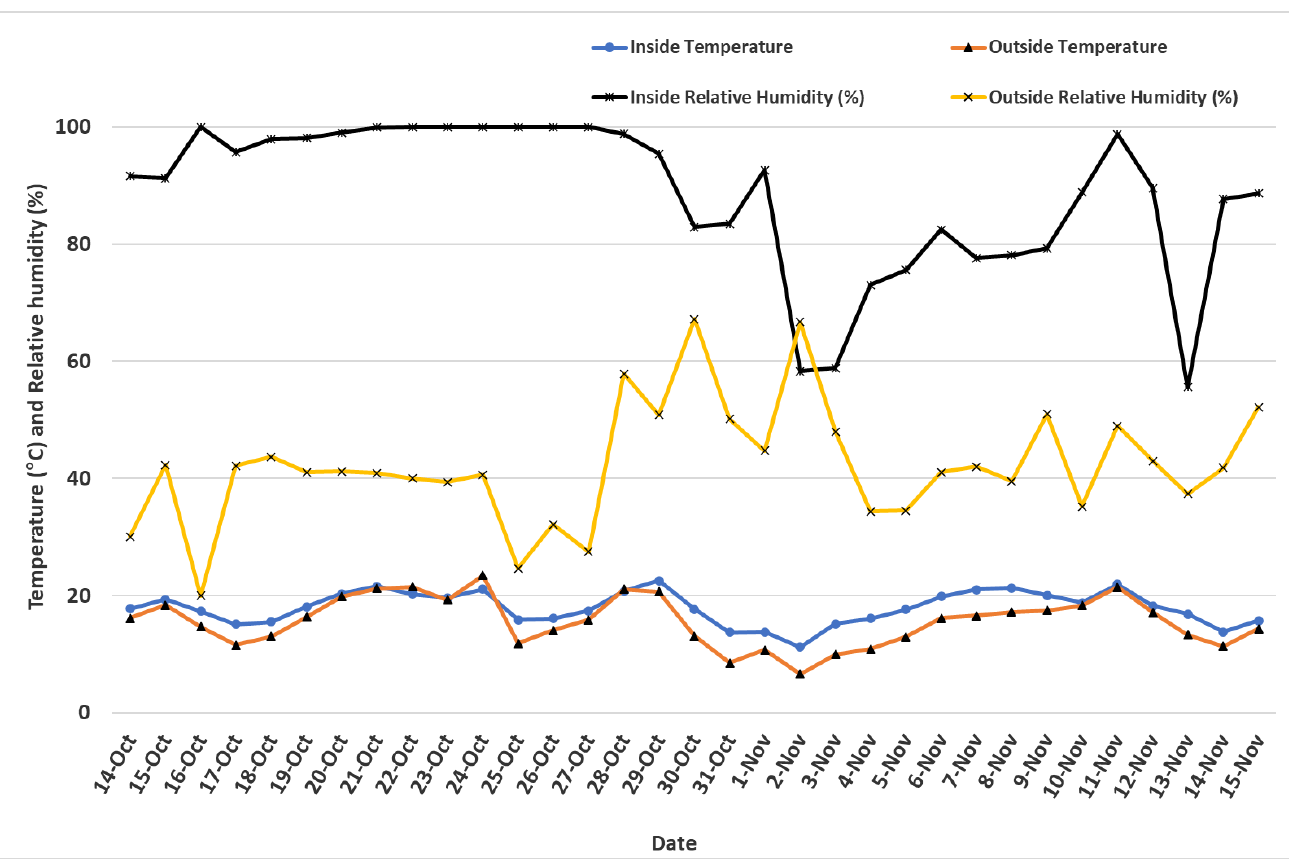
Figure 5. Contrast of temperature (°C) and relative humidity (%) inside and outside the high tunnel (HT) where the trial was conducted. A TinyTag ® data logger was placed at ground level in the middle of the HT and another one placed on a raised bed outside the HT where ginger plants were grown. Soil microbial profile. Samples sent to Microbial ID Inc. for Phospho-Lipid